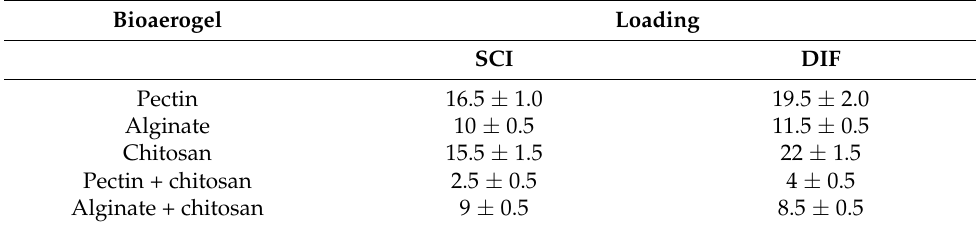
Table 2. Achieved loading for pectin, alginate, chitosan, and their composites.